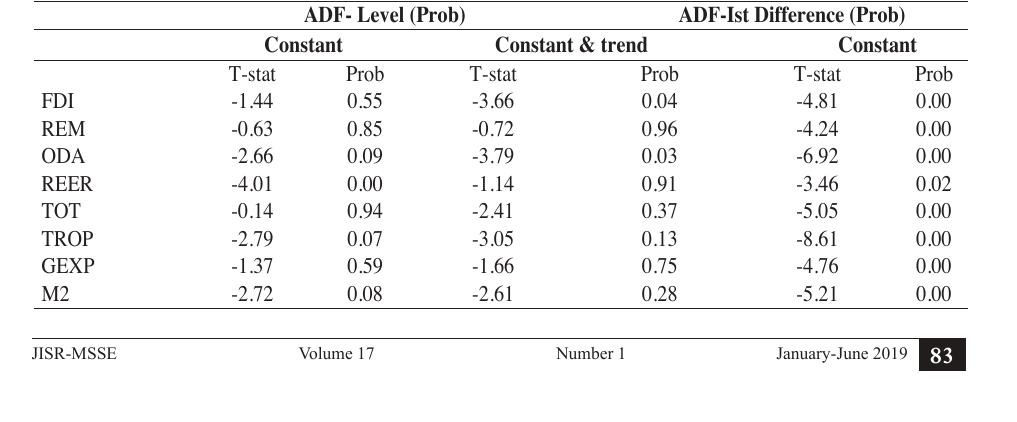
Table 2 : Unit Root